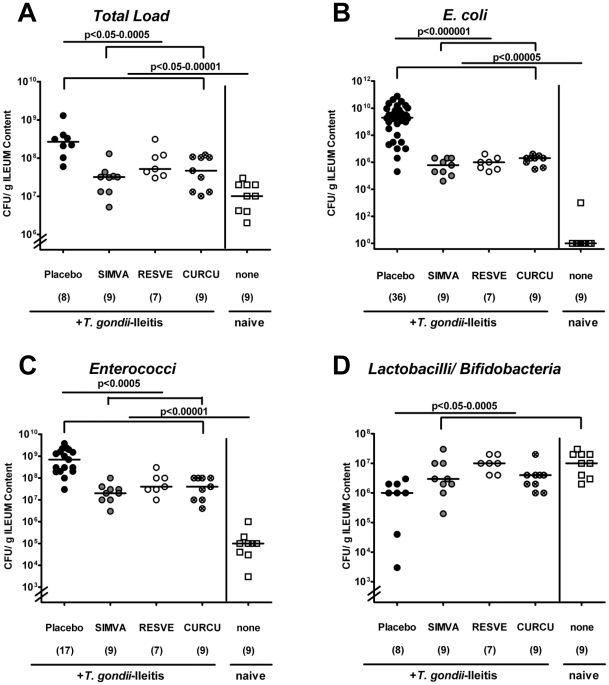
Changes in the composition of the luminal ileum flora obtained from uninfected animals (none) and T. gondii-infected mice treated with Simvastain (SIMVA), Resveratrol (RESVE) or Curcumin (CURCU) from d-2 until d8 p.i. as compared to Placebo controls (8 days after T. gondii infection).Detailed cultural analysis was performed on appropriate selective media, bacterial species identified by biochemical analysis and reconfirmed by comparative sequence analysis (see Methods). Individual bacterial counts (CFU, colony forming units) of (A) Total bacterial load, (B) E. coli, (C) enterococci, (D) lactobacilli/bifidobacteria obtained from respectively treated mice (numbers of animals are given in parentheses), medians and levels of significance determined by Mann-Whitney-U test are indicated. Data are pooled from two representative experiments.